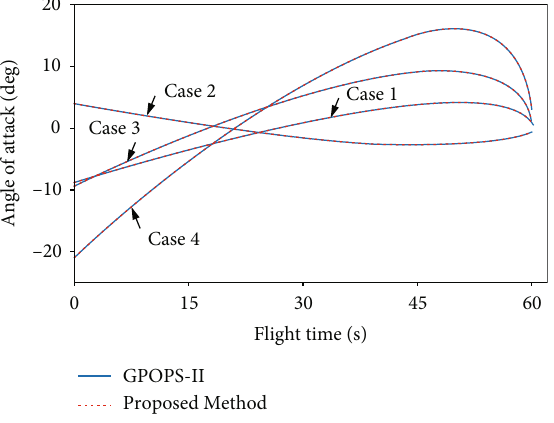
Figure 6: AOA pro fi